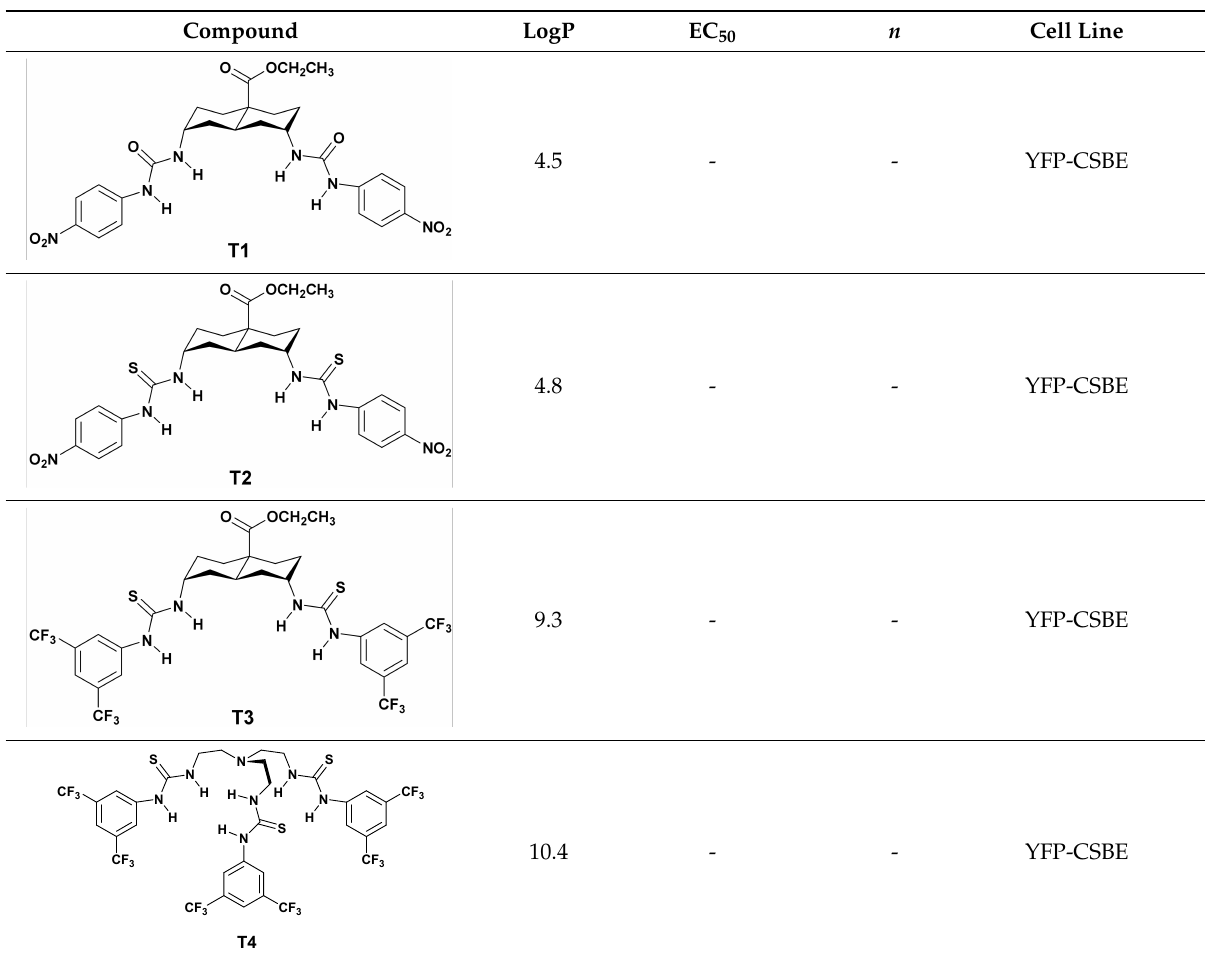
Table 3. Artificial ion transporters that were recently developed as anticancer agents. T1–T10 are selective for Cl − transport, while T11 and T12 for K +